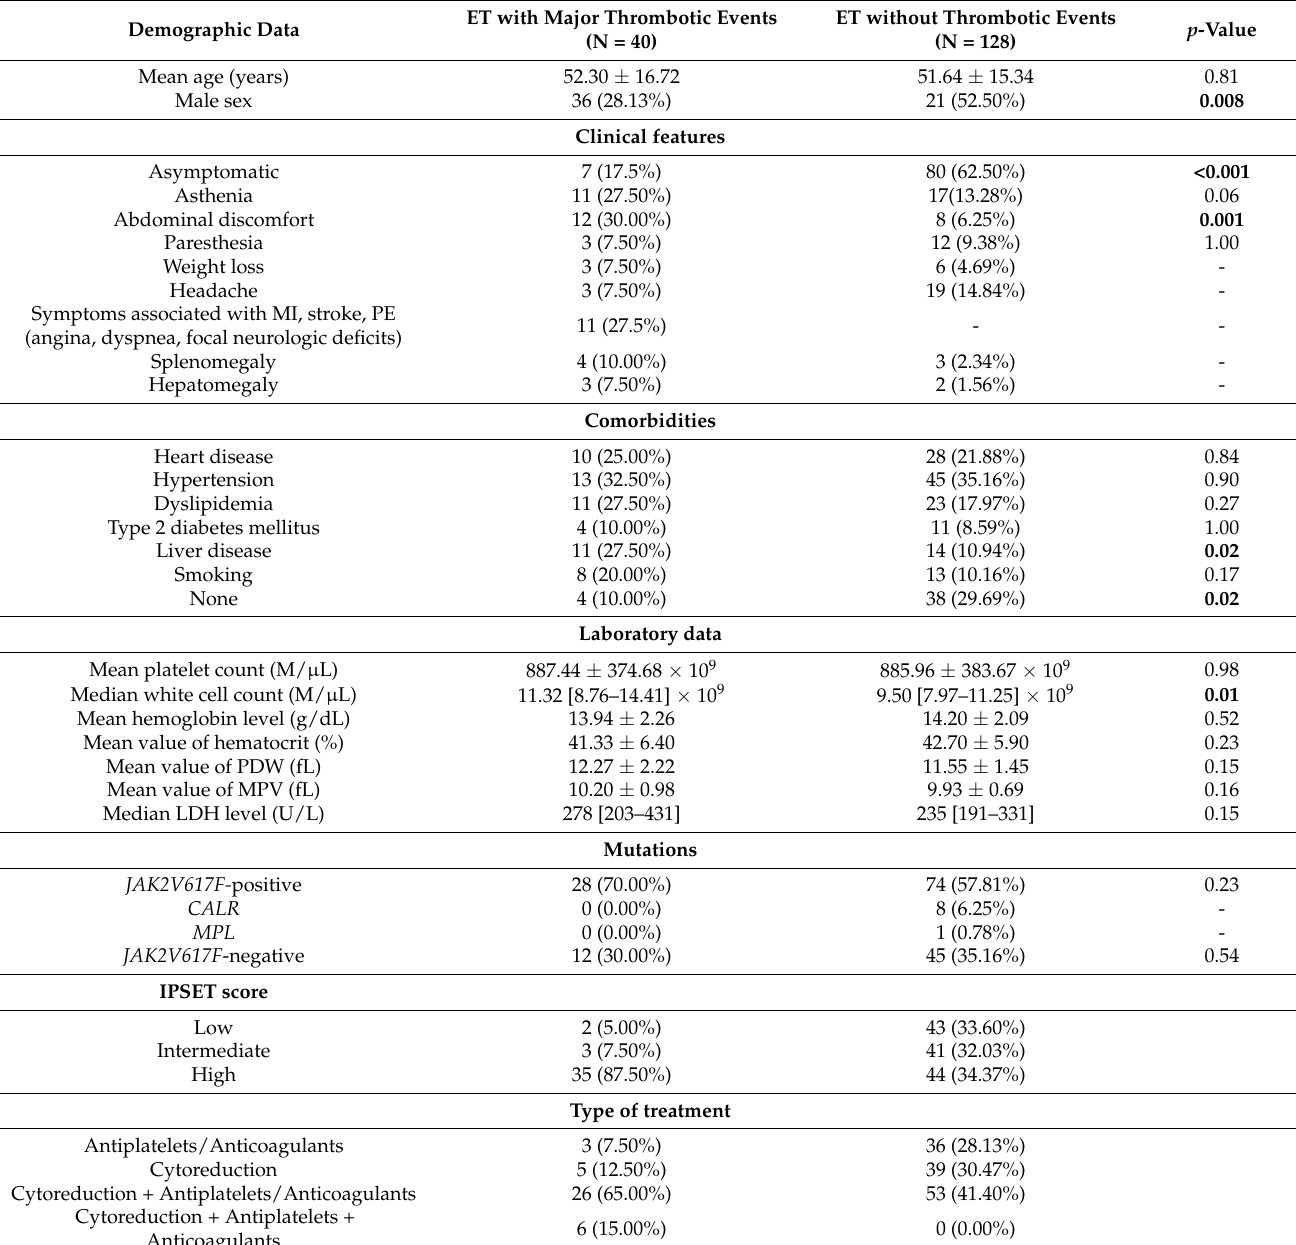
Table 3. Comparison between patients with ET with/without thrombotic events. Demographic